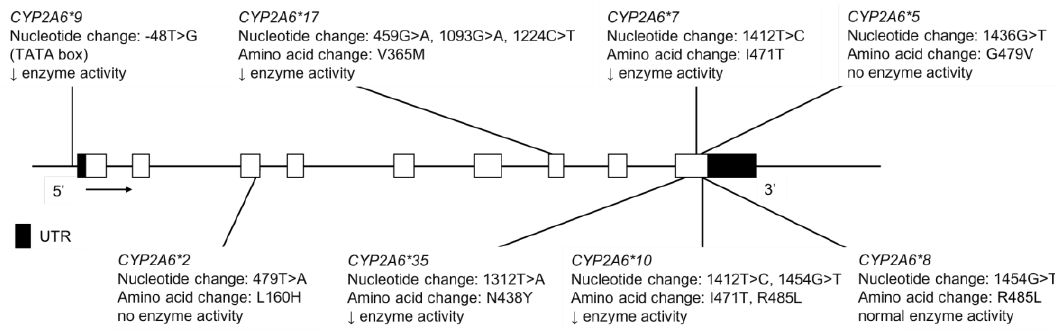
Figure 5. The human CYP2A6 gene and variants tested for in AI, AN and FN populations. Not shown are CYP2A6*4 , a full gene deletion and CYP2A6*12 , an unequal crossover event where exons 1–2 are from CYP2A7 and exons 3–9 from CYP2A6 are merged. Open boxes represent exons, lines represent introns and shaded boxes represent UTR.